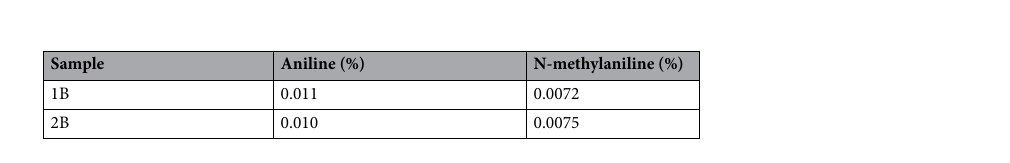
Table 2. Aniline and N-methylaniline concentration after the second acidic extraction of different indigo samples. The percentages by weight are referenced to the indigo weight.